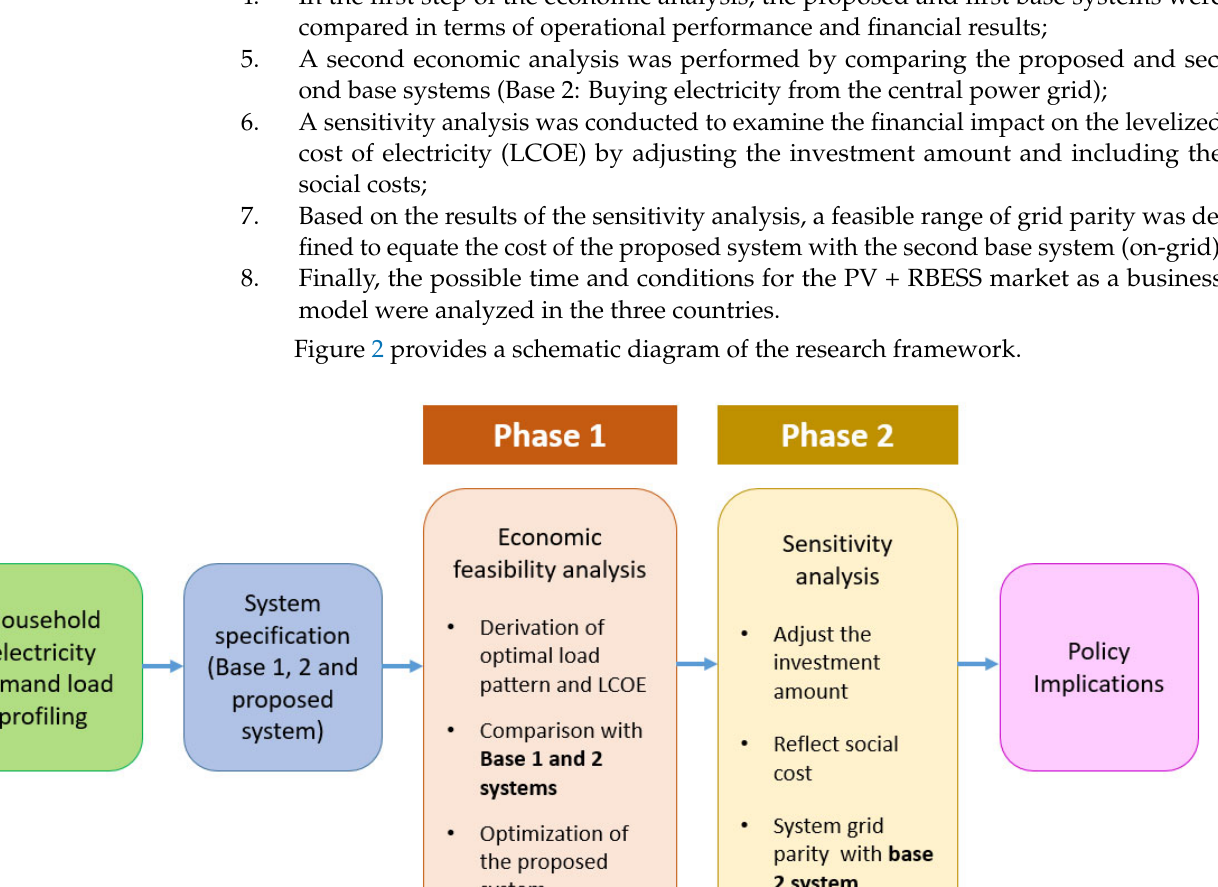
( b ) Figure 3. System c onfiguration:( a ) base system; ( b ) proposed system. In this study, the discounted cash flow (DCF) method was used according to the cash flows calculated for the base systems: diesel generators (off ‐ grid), central grid (on ‐ grid), and the proposed system (PV + RBESS). The DCF method calculates future cash flow val ‐ ues by reflecting the time value of money. The minimum attractive rate of return (MIRR) means the lowest (lower limit) rate among the expected returns of investment. Here, we applied this to the discount rate. An investment project is economically feasible if its net present value (NPV) using the rate of return is positive. Therefore, the discount rate com ‐